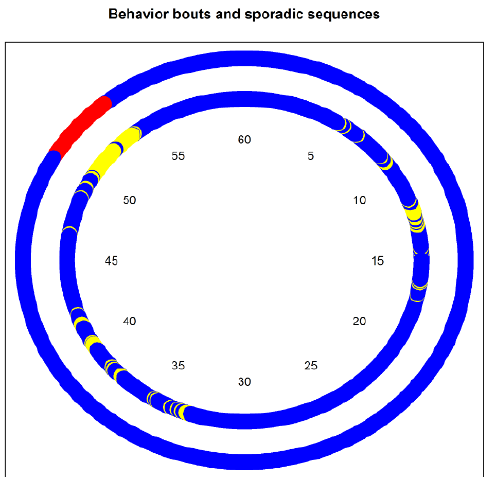
Figure 1. A random sedentary-behavior chart over an hour (based on the empirical distribution of sequence duration). In the inner circle, non-sedentary time is colored in yellow and sedentary time in blue. The outer circle represents, for the same data, the time that is regarded as non-sedentary bout is in red, and as sedentary bouts in blue. This study takes into account both bouts and sporadic sequences, although the latter is disregarded by traditional methodology. Here, 7.6 minutes were spent in NSB (yellow), and 3.4 in a NSB bout (red). The ratio time in bouts to total time is of 0.42.